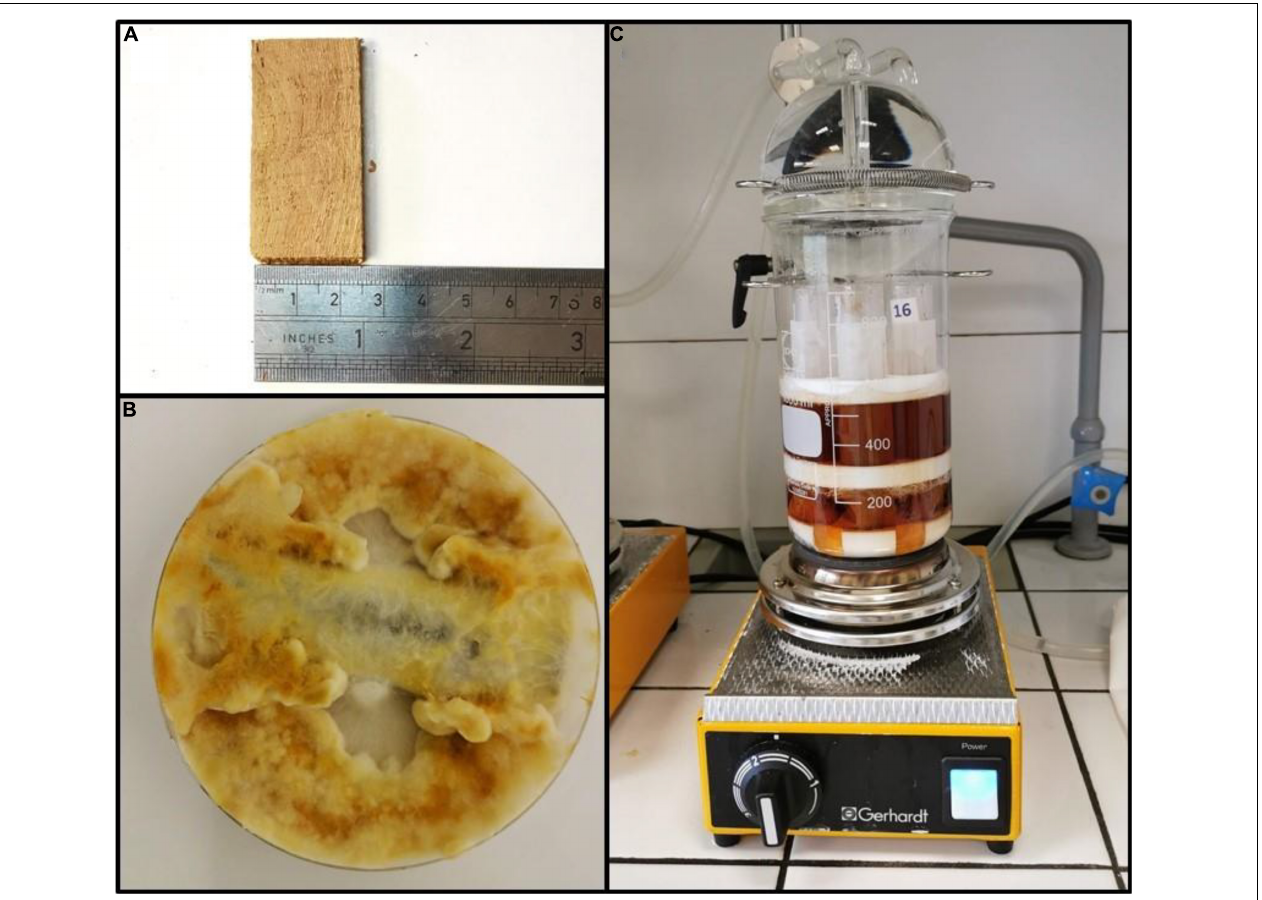
FIGURE 1 | (A) Grapevine wood block before fungal degradation. (B) Wood block incubated with Fmed in a petri dish after complete wood colonization. (C) Plastic mesh-filter bag with spacers during the detergent bath for neutral detergent fiber (NDF), acid detergent fiber (ADF), and acid detergent lignin (ADL)